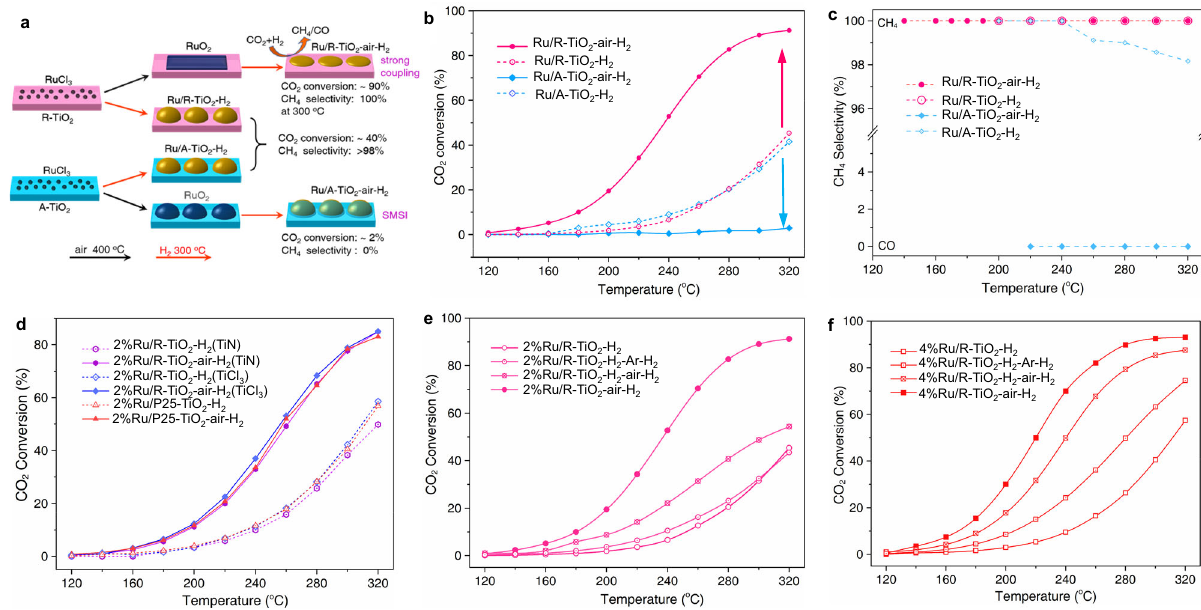
Fig. 1 Opposite catalytic performances of Ru/TiO 2 supported on rutile (R – TiO 2 ) and anatase (A – TiO 2 ) for CO 2 hydrogenation. a Summary scheme of varied activity and selectivity by direct H 2 reduction and after annealing in air. Ru/TiO 2 – H 2 refers to directly reduced catalysts by H 2 , while Ru/TiO 2 – air – H 2 refers to catalysts by annealing in air at 400°C and further reduction by H 2 . b Temperature-dependent CO 2 conversions. c Temperature-dependent CH 4 selectivity. d Temperature-dependent CO 2 conversions of 2% Ru/R – TiO 2 catalysts on other R – TiO 2 supports that were prepared from TiN and TiCl 3 , and P25 TiO 2 . Temperature-dependent CO 2 conversions by annealing ( e ) 2% Ru/R – TiO 2 – H 2 and ( f ) 4% Ru/R – TiO 2 – H 2 catalysts in Ar and air.